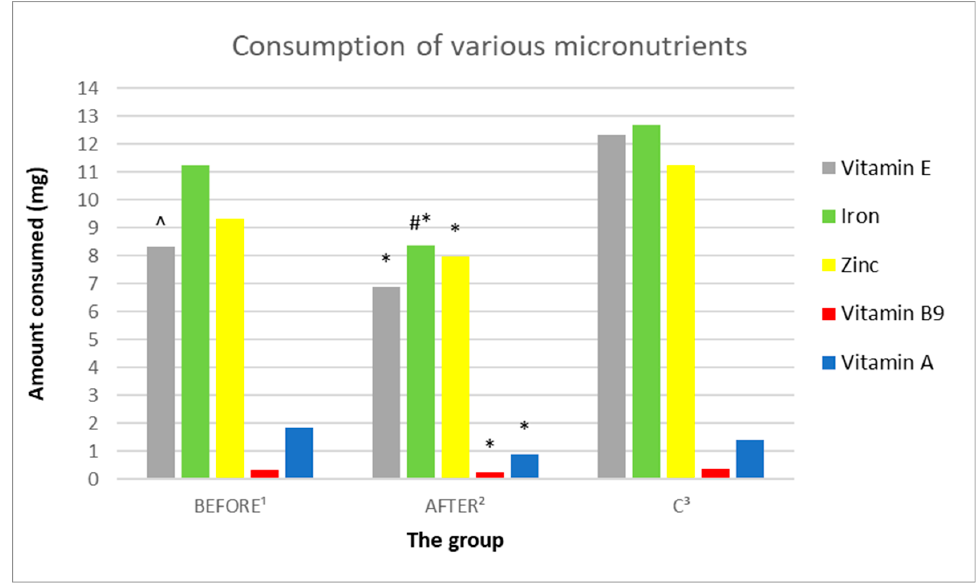
Figure 12. Average daily zinc, iron, vitamin E, B9, and A intake by groups.¹ study group prior to ketamine administration; ² study group after administration of ketamine; ³ control group; ^ means a statistically significant result p < 0.05 for the pre-ketamine group, compared to the control group; # represents a statistically significant result p < 0.05 for the group of patients after administration of ketamine compared to the group before administration; * indicates a statistically significant result p < 0.05 for the ketamine group, compared to the control